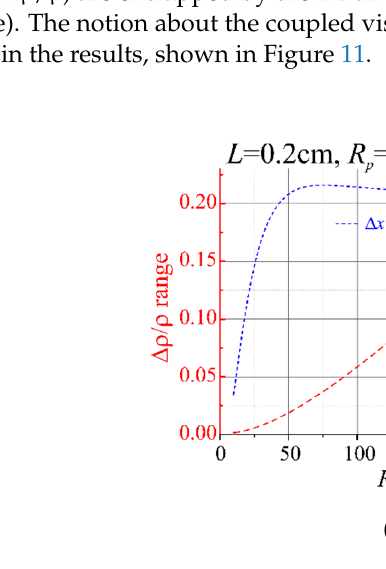
Figure 10. ( a ) Typical run of the curves τ ( R p ) for small and light particles. ( b ) Typical trajectories for a particle with R p = 1 μ m for a range of relative densities. The black dashed line concerns the case of neutrally buoyant fine particles.